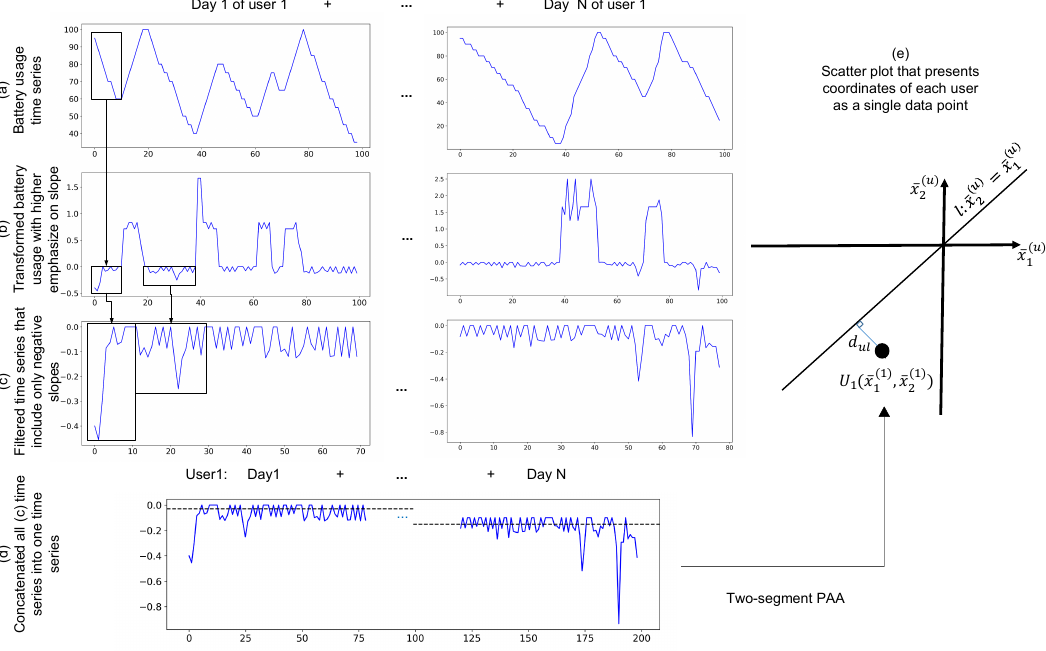
Figure 3. The block diagram for the procedure of indexing battery performance for a user. ( a ) shows the battery status for n different days for a user. ( b )Then, we calculate the slope of plots of from “a” into “b” using their time stamps ( c ) and remove the positive slope in “c” which shows the charging of the device. ( d ) After concatenating negative slopes of “c” for all days of a user, using piecewise aggregate ( u ) ( u ) approximation (PAA) in “d”. ( e ) we extract two number of ( x , x ) and make a comparison with 2 1 ( u ) = x ( u ) the benchmark line ( x ) in “e”. The mathematical equation for this equation can be found 2 1